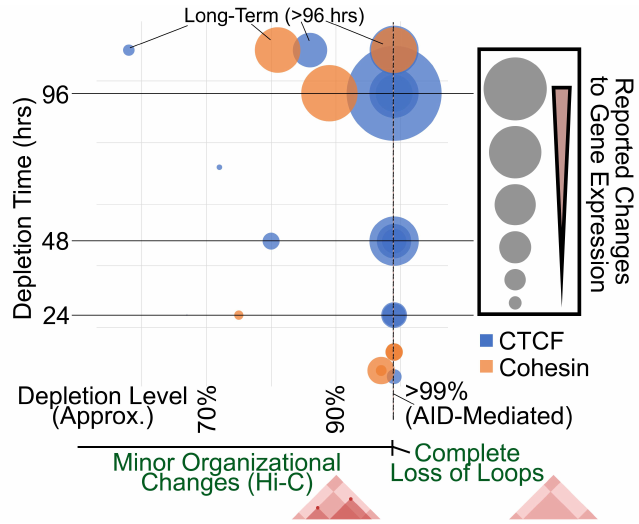
Figure 2. Gene Expression Defects in Response to Dosage and Time of depleting CTCF (blue) or cohesin (orange). Size of the circles represent the number of differential genes compiled from publicly available data in several reports [18,19,30–32,34,35,37–41]. Depletion levels in these reports were often approximated or the midpoint was plotted if a range was given. AID studies often report “complete depletion” and thus were plotted as “>99%”. Depletion times larger than 96 h were plotted as “long-term”. Concentric circles indicate different studies that used similar depletion time and level, but reported different numbers of differential